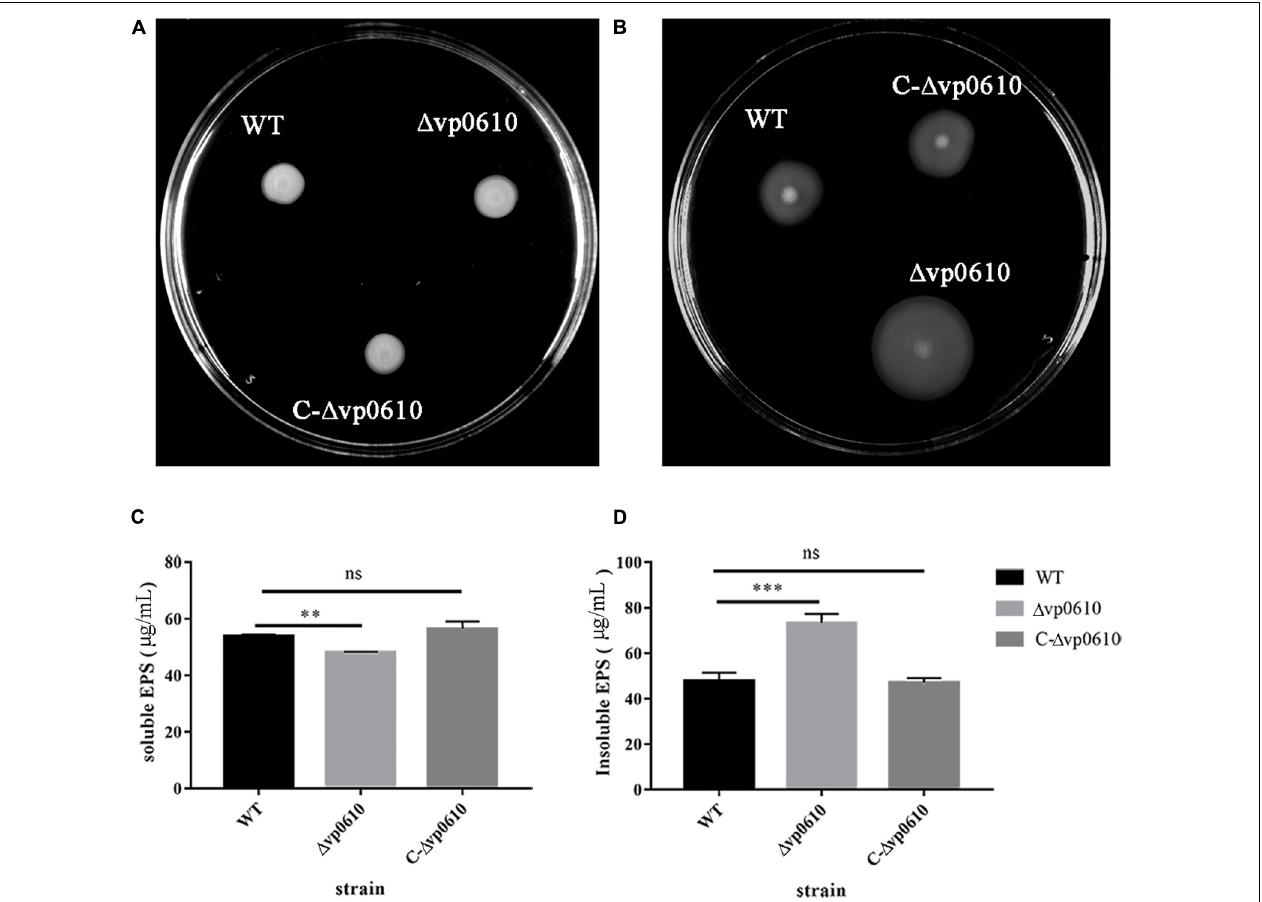
FIGURE 3 | VP0610 can enhance swimming ability and insoluble EPS but decrease soluble EPS. (A) Three different strains of V. parahaemolyticus were inoculated into LB (0.2% agar) and incubated at 37 ◦ C for 8 h; (B) Three different strains of V. parahaemolyticus were inoculated into LB (1.5% agar) and incubated at 37 ◦ C for 48 h; (C) Soluble EPS determination; (D) Insoluble EPS determination. Soluble and insoluble EPS were extracted from biofilms attached to the bottom of beakers and then determined by phenol-vitriolic colorimetry. Significance was determined by analysis of variance and Dunnett’s test comparison for differences from EPS production. ** p < 0.01; *** p < 0.001; ns,